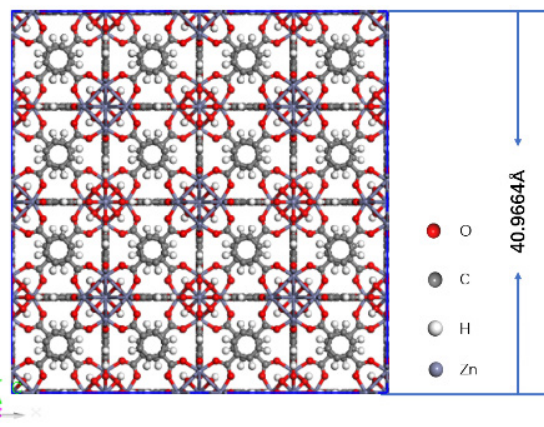
Figure1: 2×2×2 unit cells of UIO-66 structure.